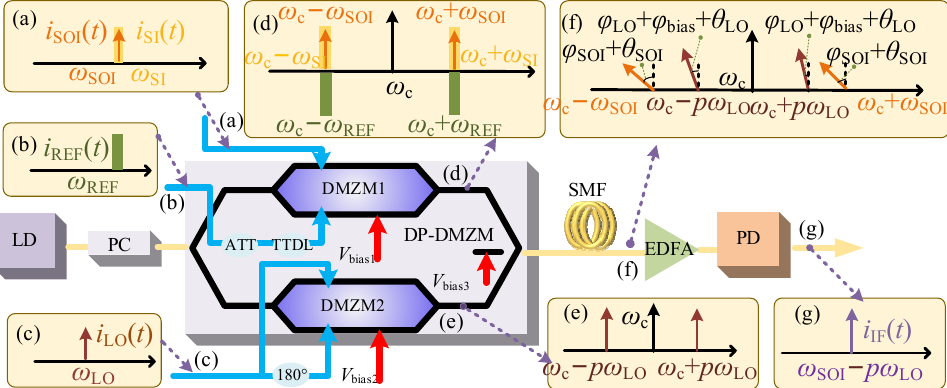
Figure 1. Schematic diagram of the proposed scheme with capabilities of SIC, high-efficiency HDC, and DIPF compensation. LD: laser diode; PC: polarization controller; DP-DMZM: dual-parallel dual-drive Mach–Zehnder modulator; DMZM: dual-drive Mach–Zehnder modulator; 180° HC: 180° hybrid coupler; ATT: attenuator; TTDL: tunable time delay line; SMF: single-mode fiber; EDFA: erbium- doped fiber amplifier; PD: photodetector.